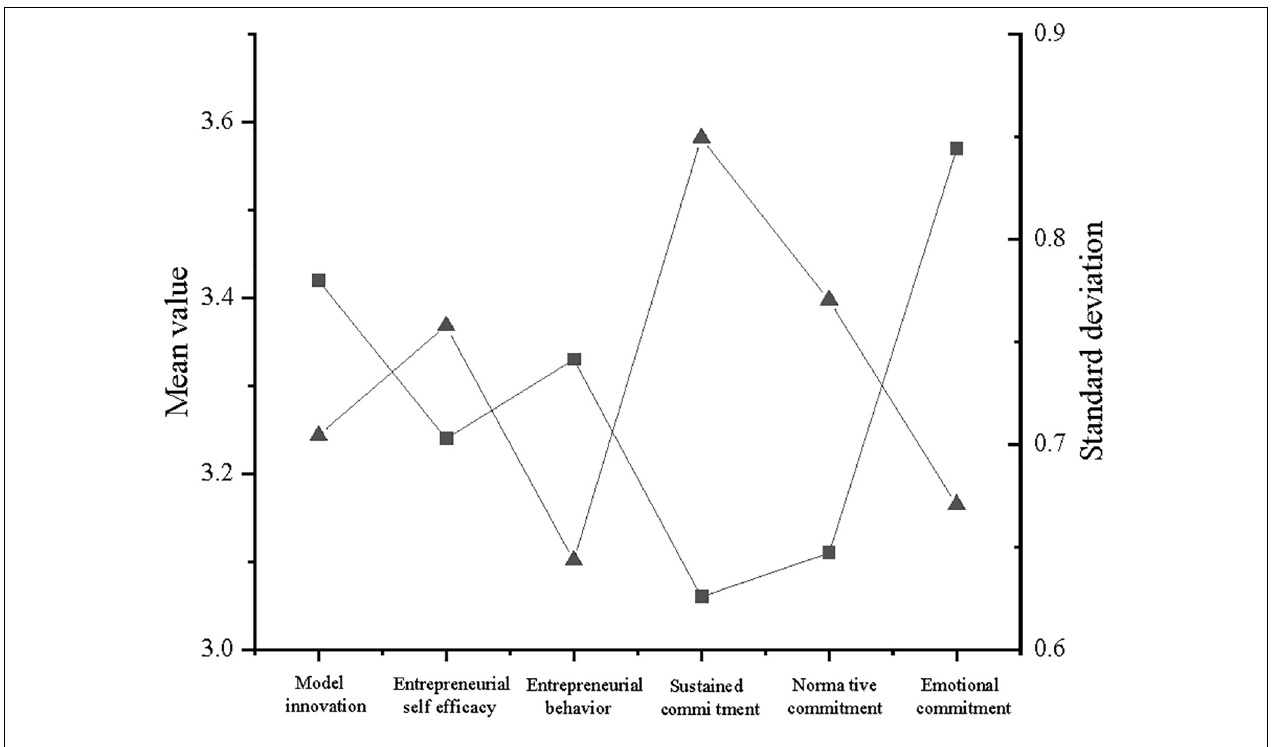
FIGURE 5 | Descriptive statistics of variables.